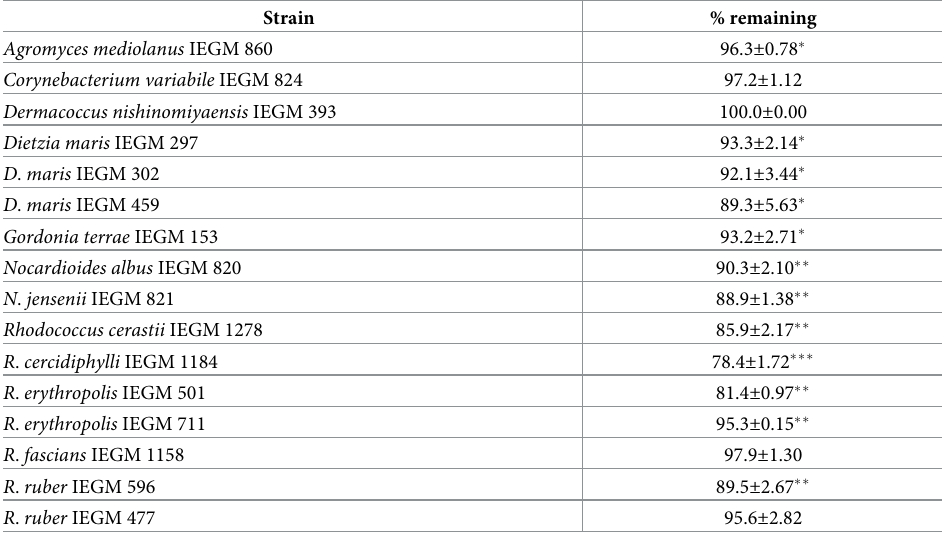
Table 2. Percentage of IBP (100 mg/L) remaining during biodegradation experiment after 7 days of incubation of the actinobacterial strains in the RS medium.